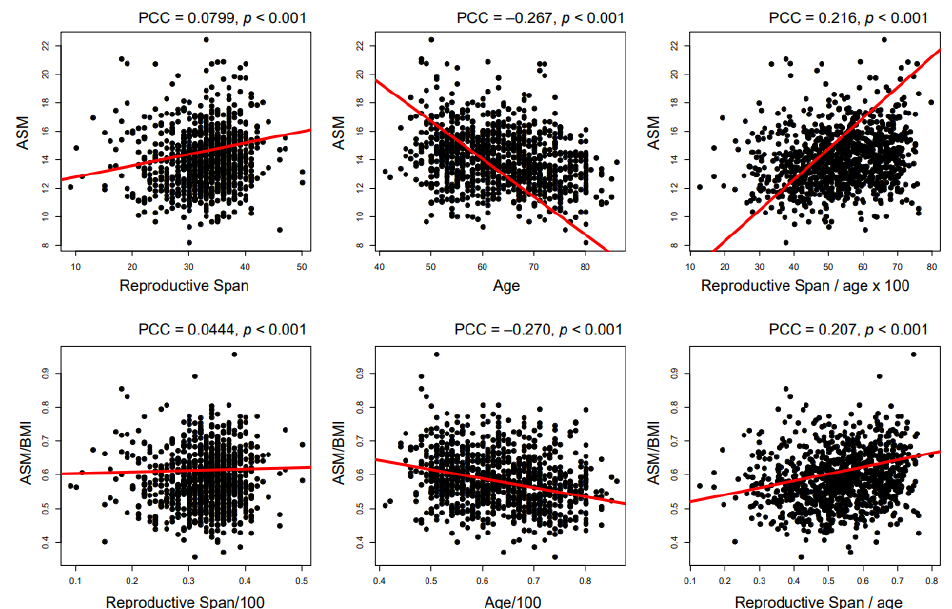
Figure 1. Association between reproductive span and muscle amount. (ASM, appendicular skeletal muscle; BMI, body mass index; PCC, Pearson correlation coefficient).